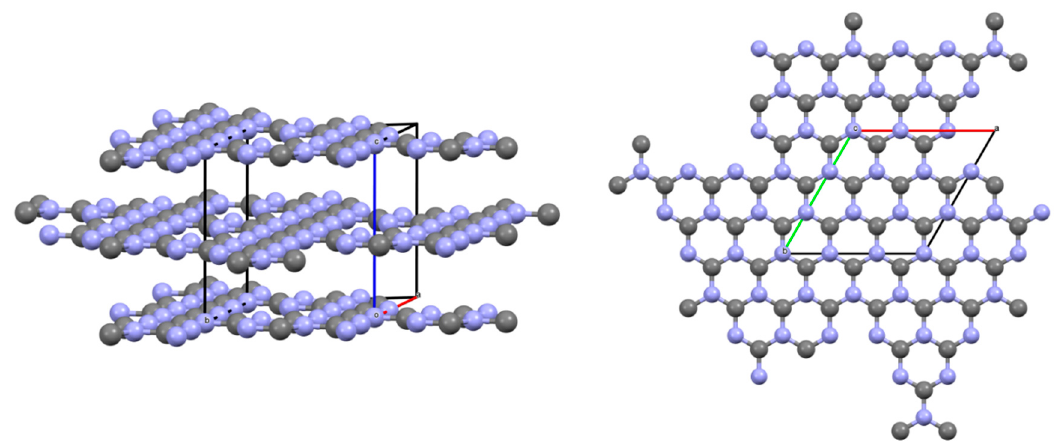
Figure 12. Crystallographic model of the structure of g ‐ C 3 N 4 .